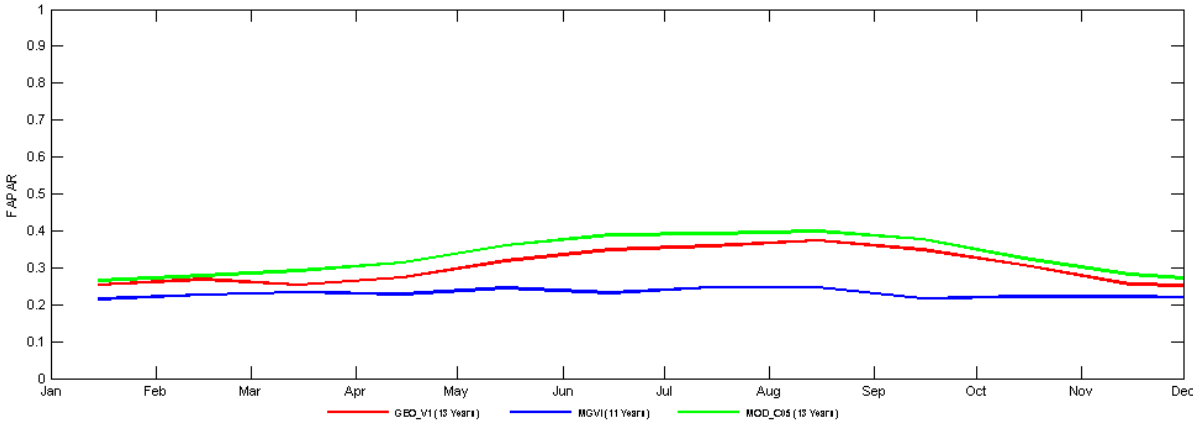
Figure 8. Average global seasonality computed for the three products: GEOV1 (red), MGVIo (blue) and MODC5 (green). Products are displayed at their original temporal resolution (Table 2). The 49 × 49 pixel values are averaged over all the BELMANIP2 sites, and then averaged over years for the period defined in the validation